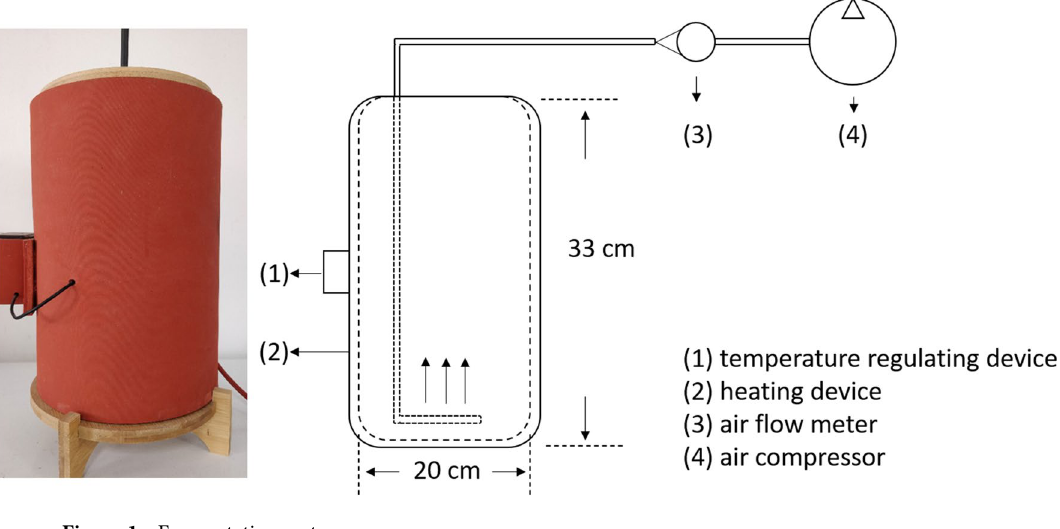
Figure 1. Fermentation